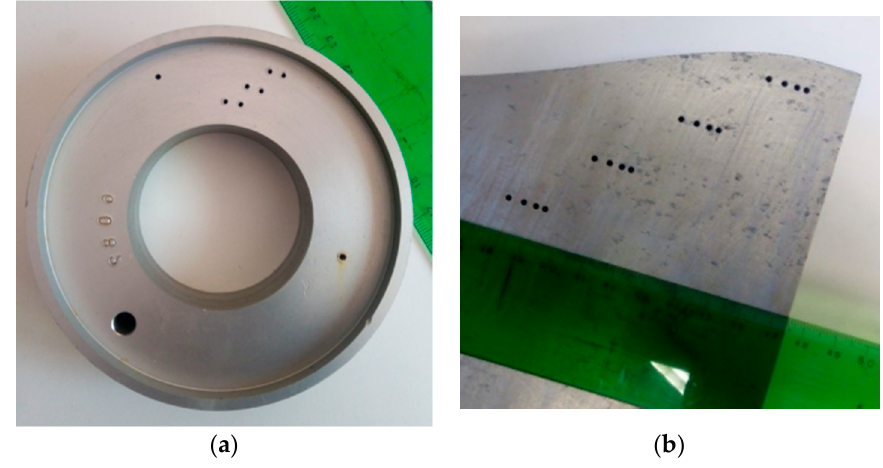
Figure 9. ( a ) Test piece A. ( b ) Test piece B.